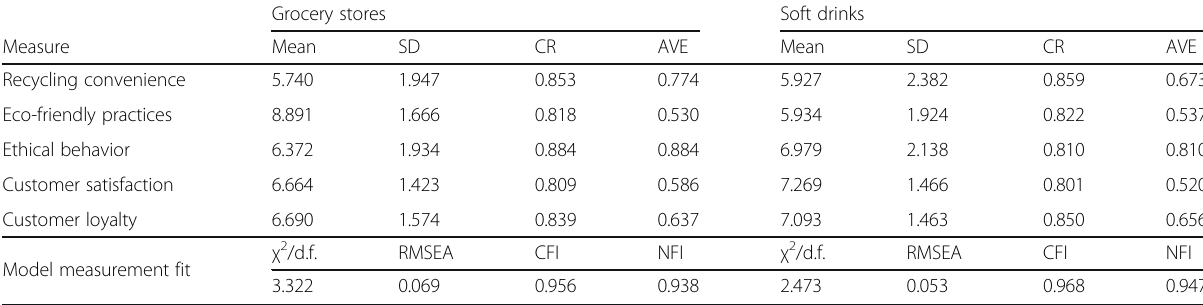
Table 1 Descriptive statistics and psychometric properties of constructs Grocery